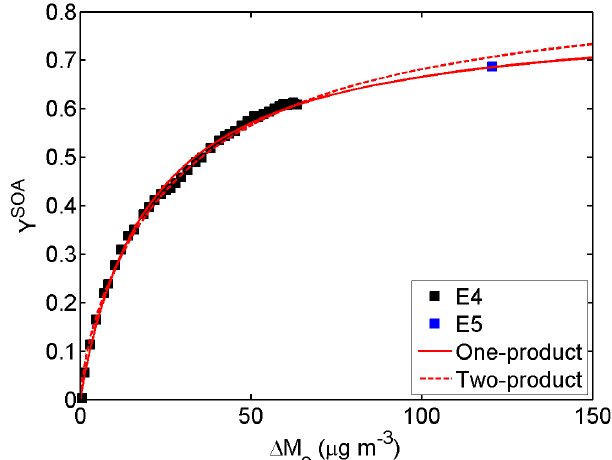
Fig. 2. Secondary organic aerosol yields in the OH-initiated ox- idation of MEA as function of organic mass concentration (mea- sured by AMS) in experiment E4 and E5. Data are shown as filled squares. Curves were fitted to the data using the one-product model (solid line) and the two-product model (dashed line). Parameters obtained from the fit are given in Table